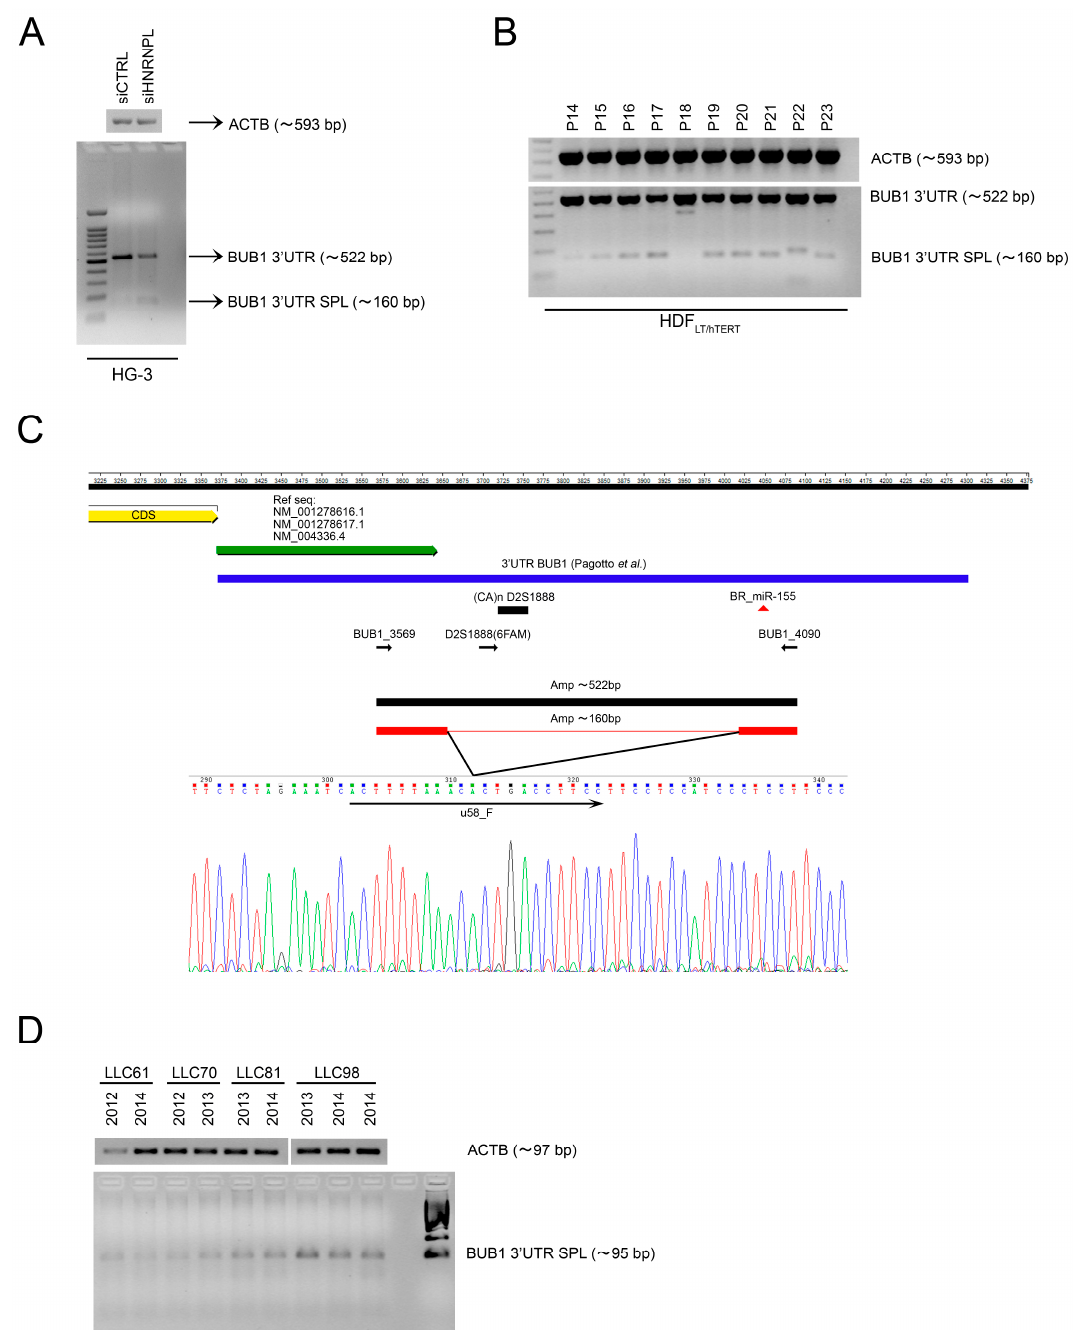
Figure 5. BUB1 3 (cid:48) UTR characterization. ( A ) Detection of the ~522 and ~160 bp BUB1 3 (cid:48) UTR amplicons by RT-PCR followed by gel electrophoresis in HG-3 cells after depletion of HNRNPL and ( B ) during the immortalization of HDF LT / hTERT (1.5% agarose gel in 0.5 × TBE bu ff er and ethidium bromide staining). ( C ) Schematic representation of BUB1 3 (cid:48) UTR shows, from top to bottom: 3 (cid:48) end of the coding sequence (yellow arrow); NCBI / Ensembl reference 3 (cid:48) UTR sequence (green arrow); BUB1 3 (cid:48) UTR sequence identified in Pagotto et al. (blue box) [6]; D2S18888 polymorphic marker (black box); predicted miR-155 binding site (red triangle); and PCR primers (black arrows). On the bottom, sequence chromatograms of BUB1 3 (cid:48) UTR spliced form. ( D ) Detection of the ~95 bp amplicon of BUB1 3 (cid:48) UTR spliced form by RT-PCR followed by gel electrophoresis in eight PBMC sequential samples from four di ff erent CLL